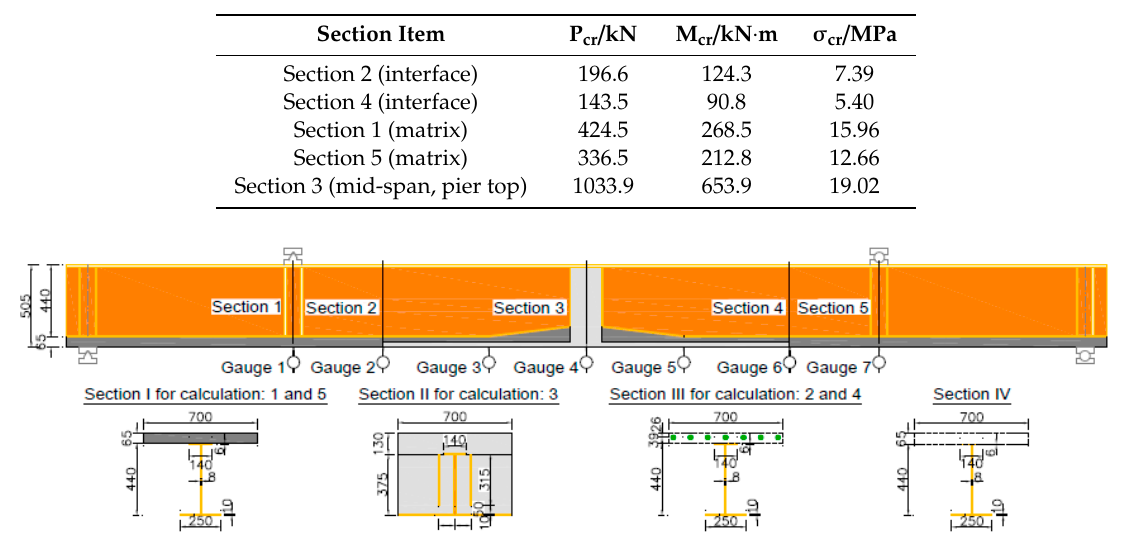
Figure 12. Gauge and calculation sections layout.